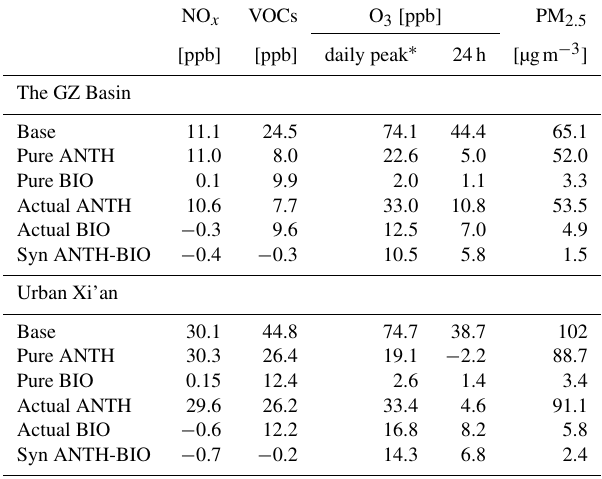
Table 4. The various contribution components of the simulated O 3 (and the precursors) and PM 2 . 5 in August